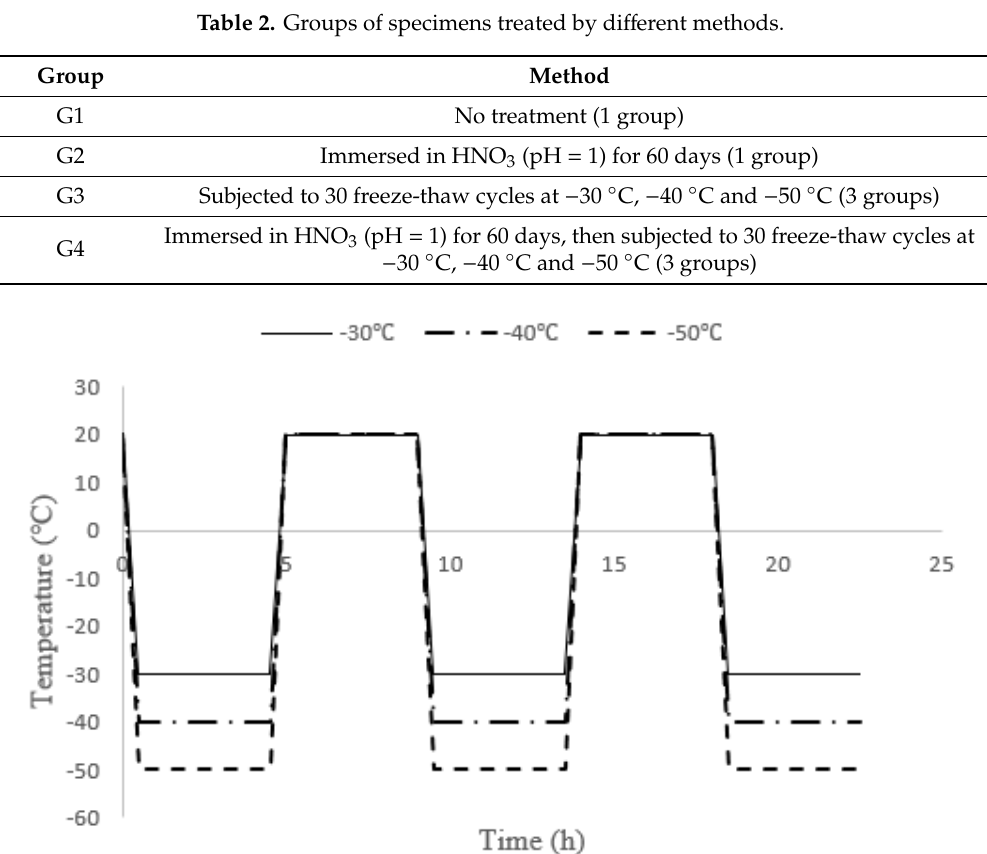
Figure 2. Temperature variation of freeze-thaw cycles for tonalite specimens.